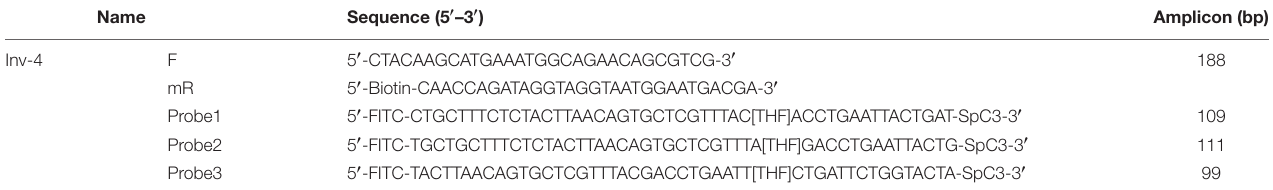
TABLE 4 | Primer probe set Inv-4 sequences and chemical